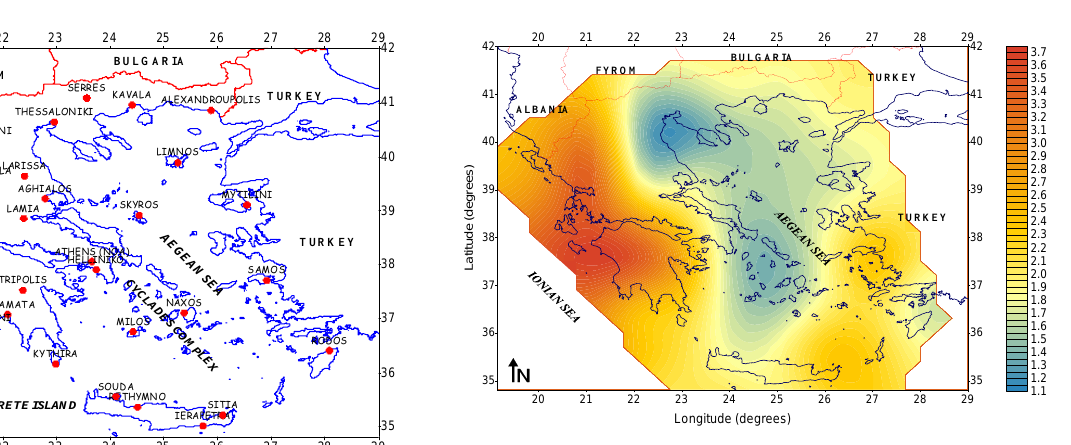
Figure 2 . Spatial distribution of the mean annual RI (mm/h), in Greece, during the period 1962-2002.